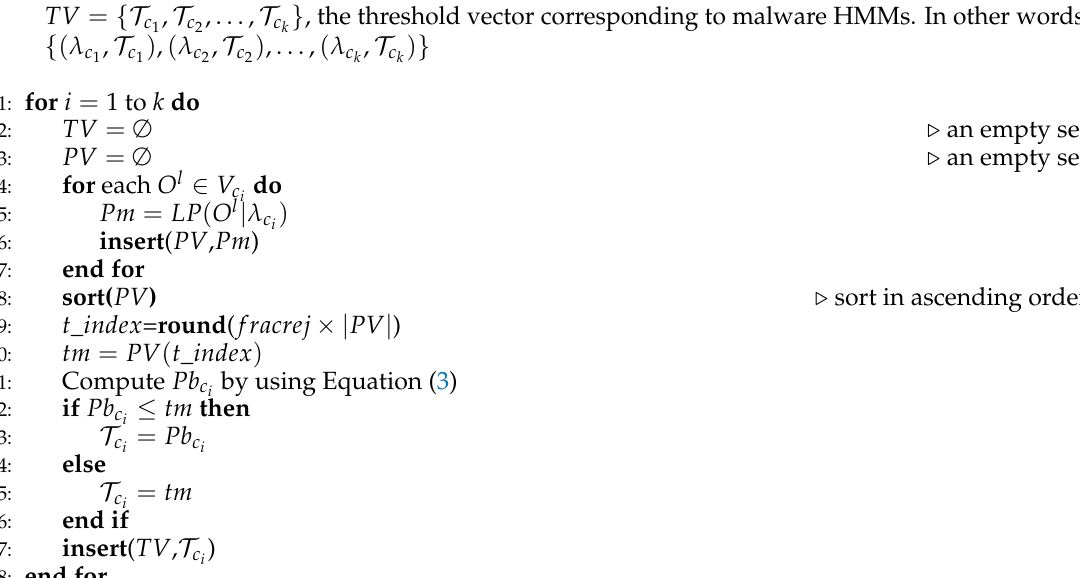
Algorithm 3 : Computing decision thresholds for all malware HMMs, λ c